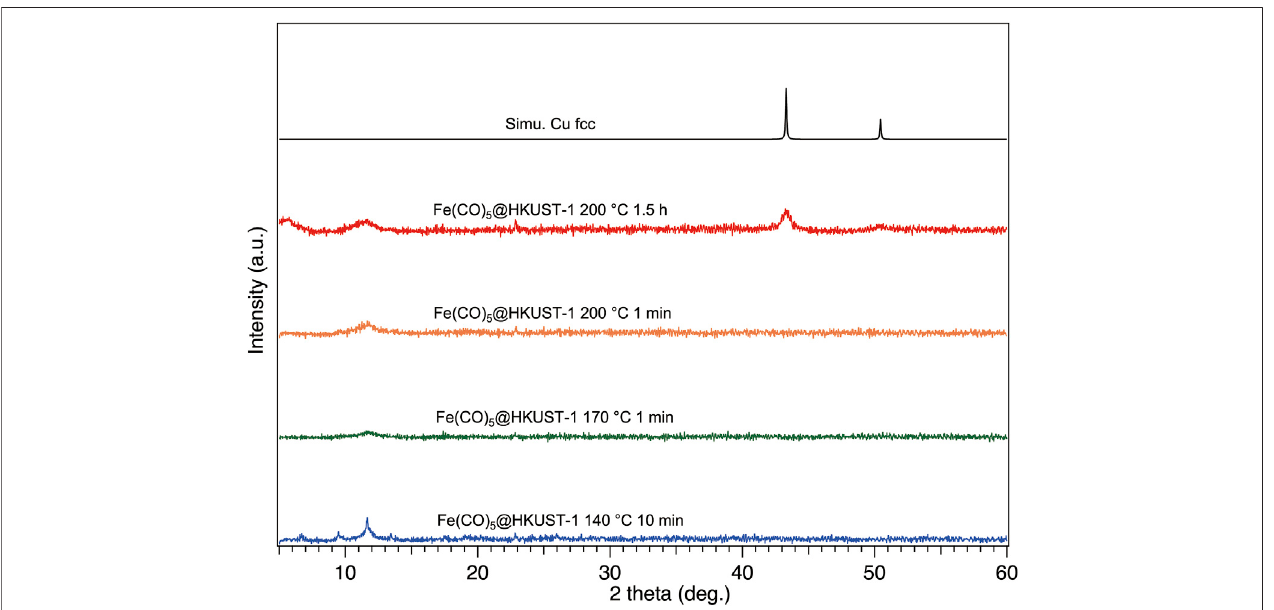
FIGURE 3 | XRPD patterns of Fe(CO) 5 @HKUST-1 decomposed at different conditions: 140 ° C-10 min (blue), 170 ° C-1 min (green), 200 ° C-1 min (orange), 200 ° C- 1.5 h (red), and simulated Cu (black). All samples were sealed inside a glovebox and measured under inert conditions. The background of XRPD patterns had been removed for clarity. The radiation wavelength was 1.5406